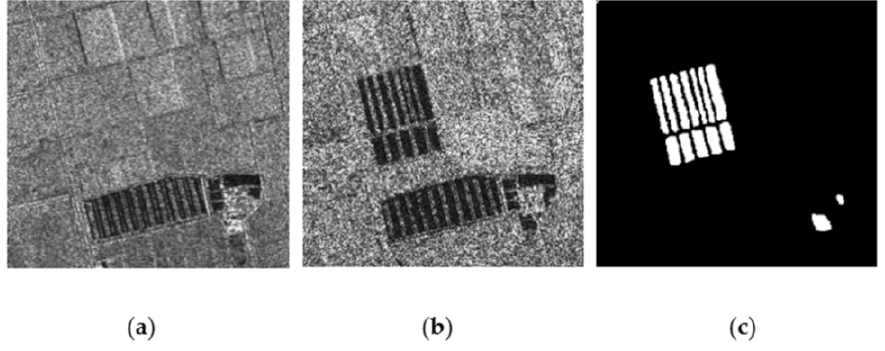
Figure 11. Farmland C dataset with a 3-m resolution. ( a ) Image acquired in June 2008. ( b ) Image acquired in June 2009. ( c ) Ground